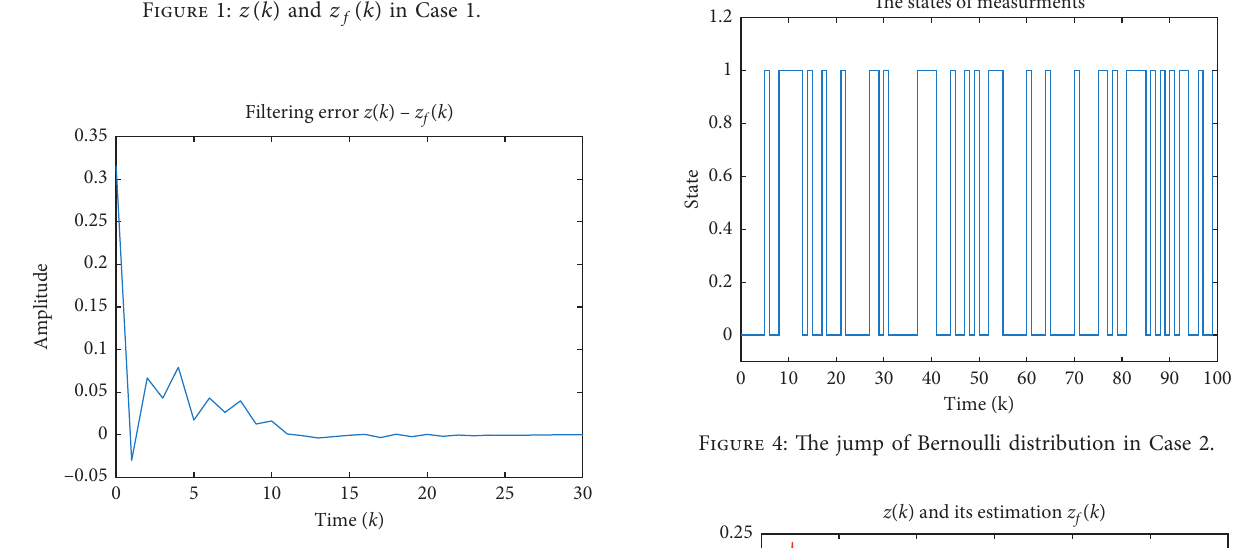
Figure 2: The filtering error in Case 1.